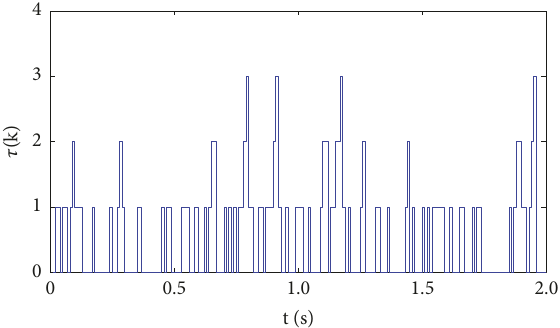
Figure 2: Distribution of equivalent time delay.